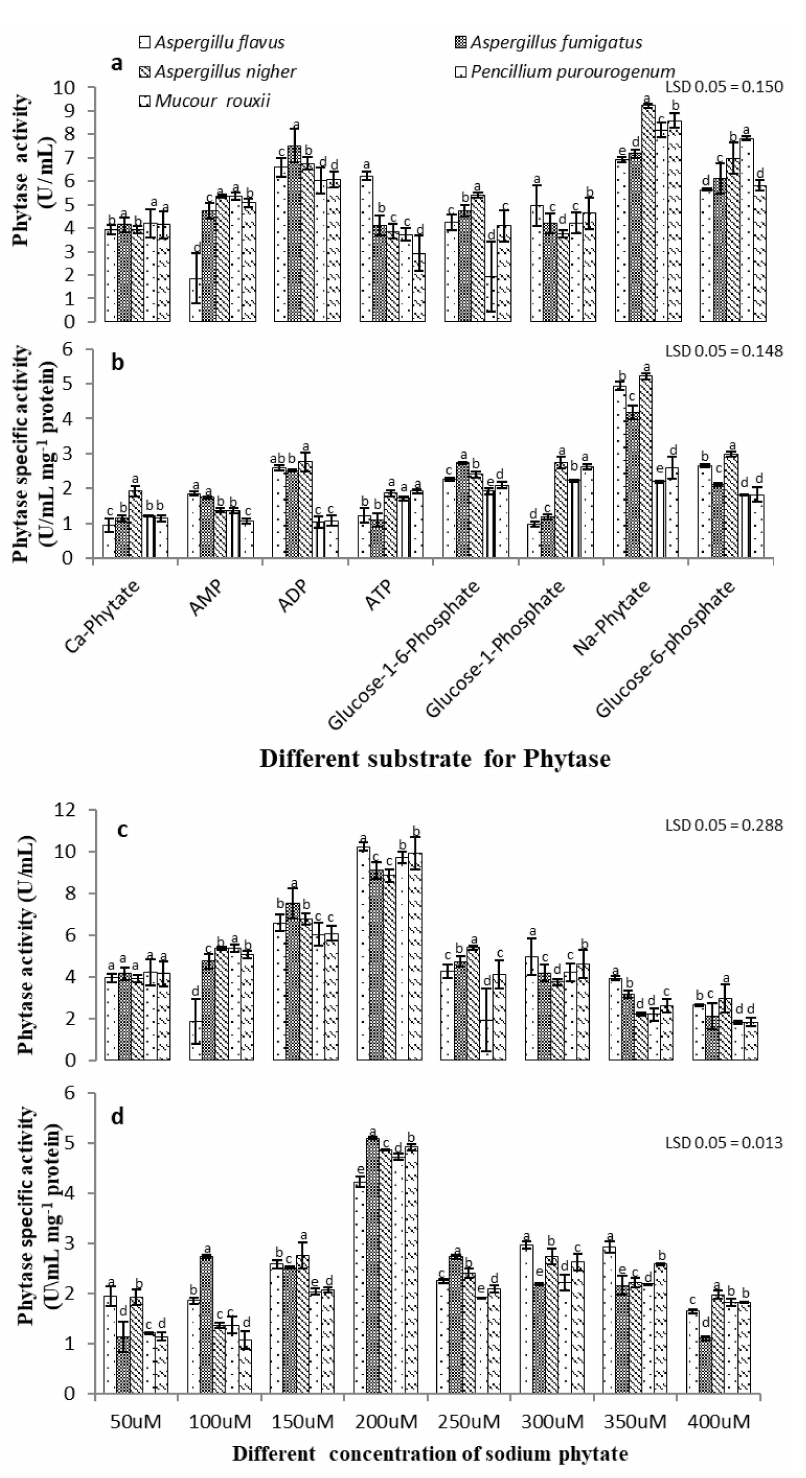
Figure 2. Different substrates for phytase and different concentrations of sodium phytate: modu- lation with substrates in ( a ) phytase activity and ( b ) phytase specific activity; and with different concentration of the best substrate in phytase activity ( c ) and phytase specific activity ( d ) of the selected fungi ( Aspergillus niger , Aspergillus flavus , Aspergillus fumigatus , Penicillium purourogenum and Mucor rouxii ). The given LSD value at 0.05 level refers to the significant differences among mean values of each